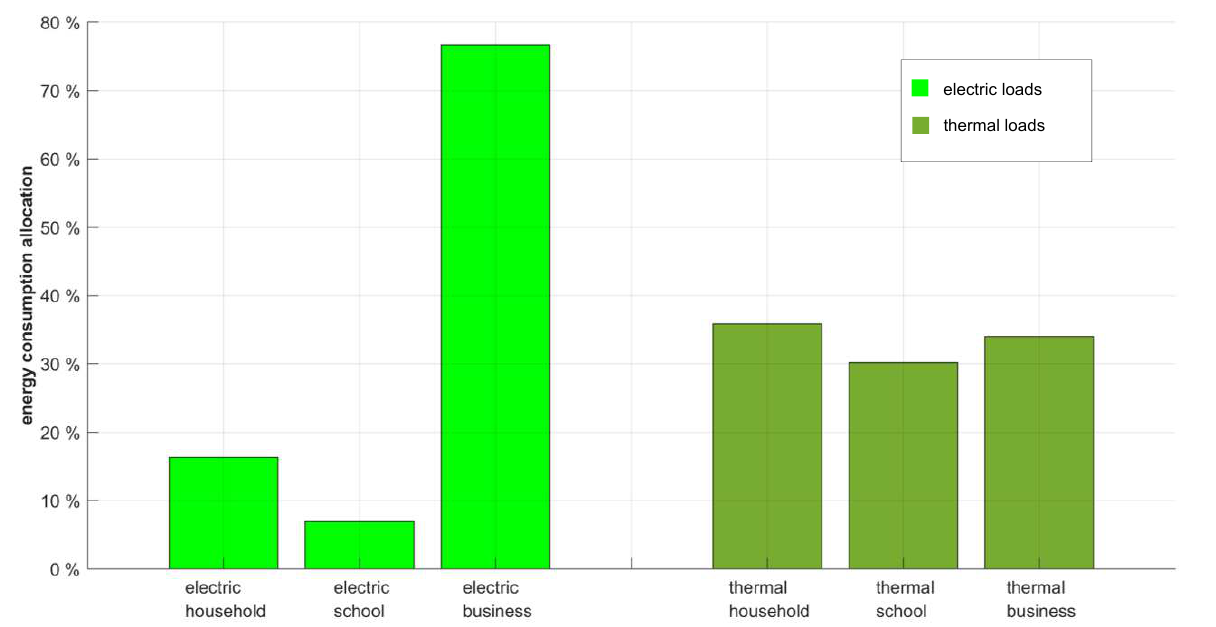
Figure 2. Electricity and heating demand